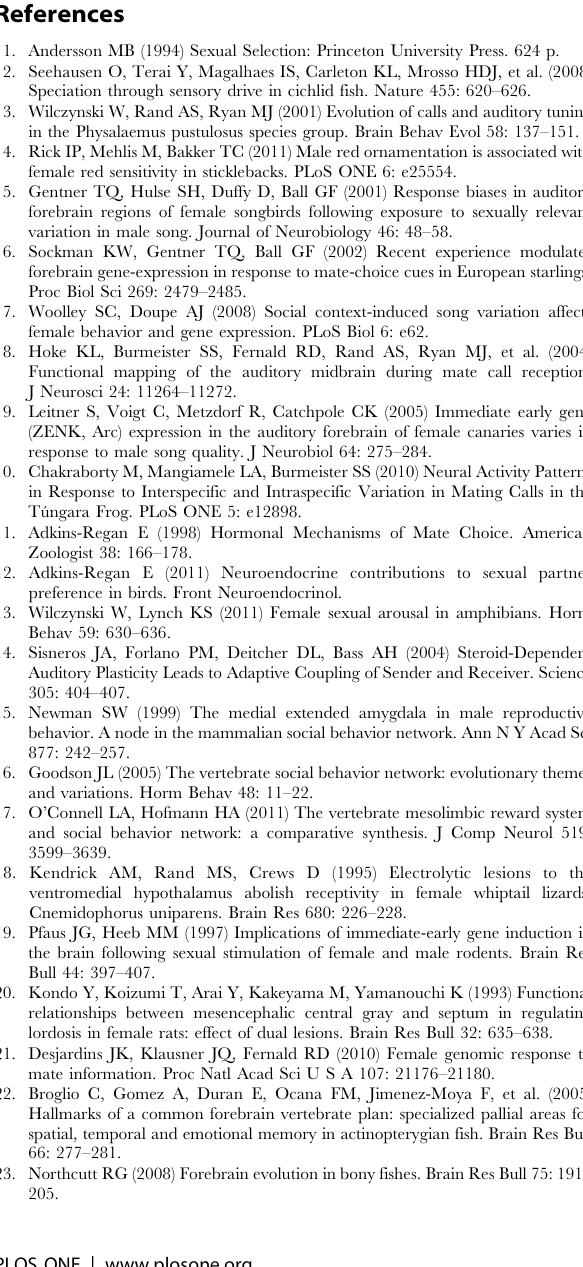
Table S3 Neuroserpin optical density (mean ± SE) comparisons between ‘‘high’’ ( . median) and ‘‘low’’ ( , median) behaviors. n.s., not significant. Table S4 Correlations between preference score and gene expression in Dm, Dl, POA in non-sexual contexts. Table S5 Correlations between glides, transits and gene expression in Dm, Dl, POA in male exposed environ- ments. Table S6 Correlation between circulating estradiol levels and preference score, glides, transits, and gene expression in different brain regions for each treatment